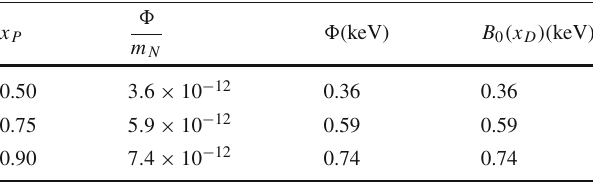
Table 1 A table showing the different values of the constant (cid:9) and the background field B 0 with respect to different expansion points x P at the decoupling value of x D = 1